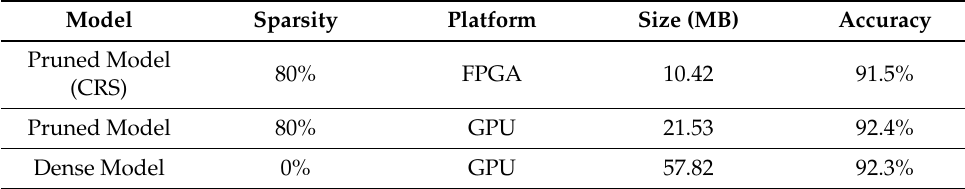
Table 2. Size and Accuracy of the model running on FPGA and